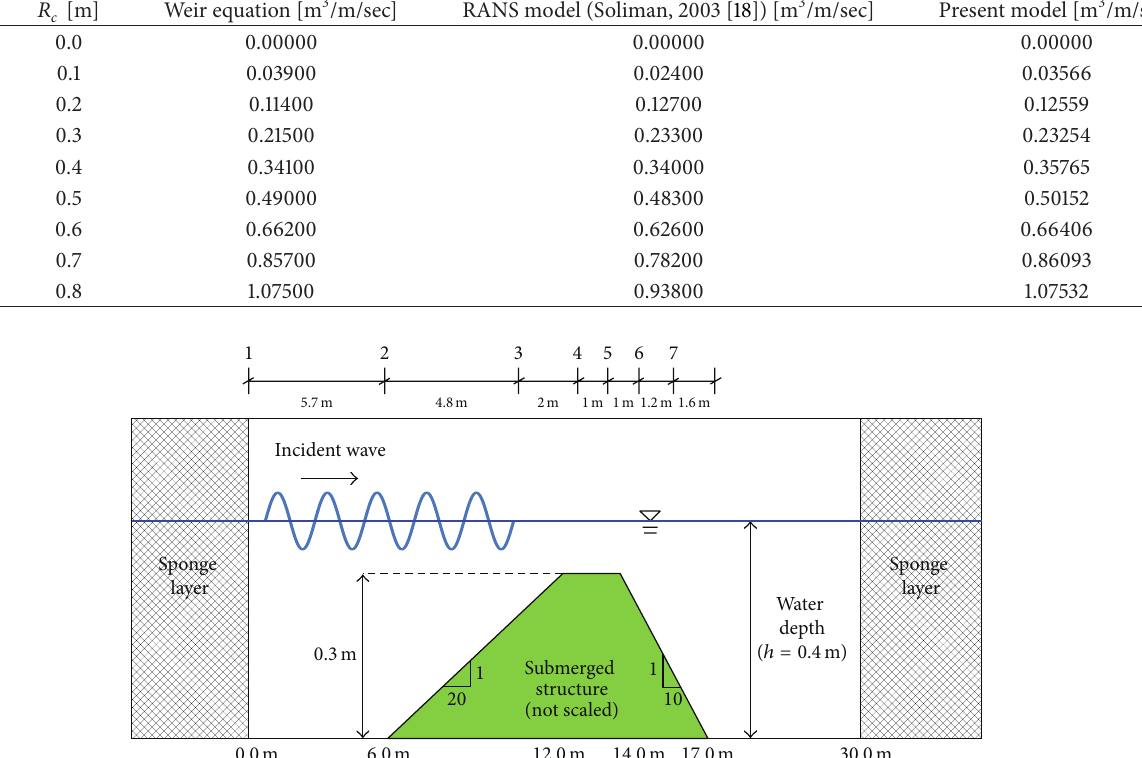
Table 1: Rates of overtopping discharges for different freeboards.